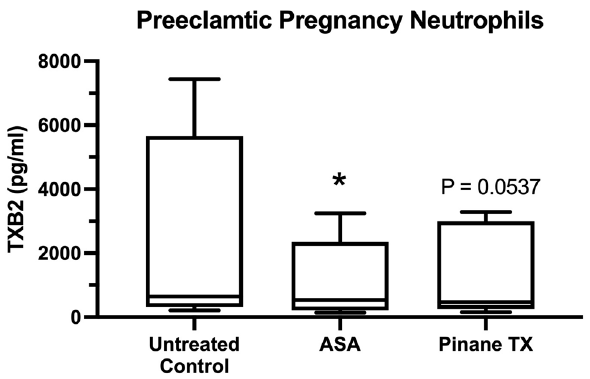
Figure 7. Media concentrations of TXB2 in preeclamptic pregnancy neutrophils treated with aspirin or pinane TX. ( n = 5, * p = 0.0228; ASA,